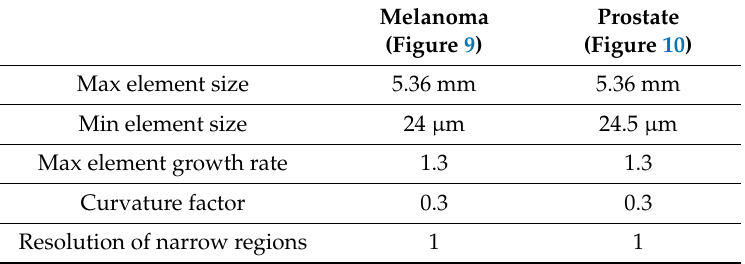
Table 3. Parameters of the meshes for the corresponding geometries of melanoma and prostate